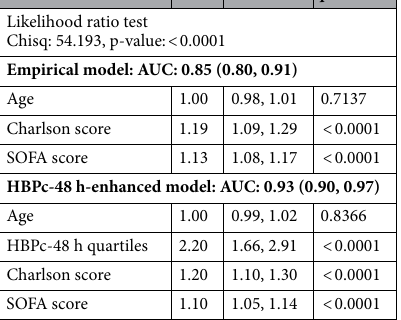
Table 4. Multivariable binary Cox regression analysis of prognosis in patients with severe sepsis or septic shock using age as a continuous